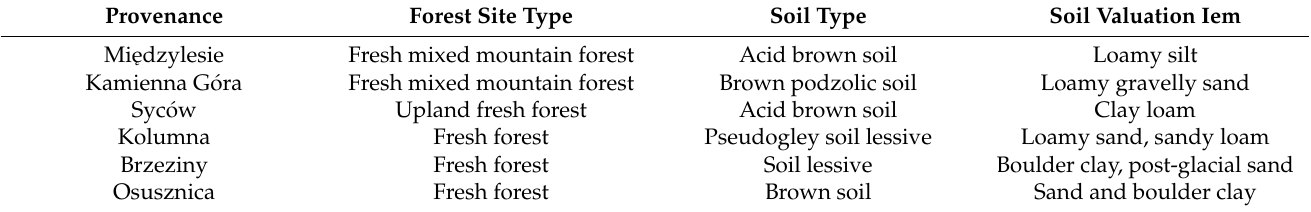
Table 2. Soil conditions of the stands where Abies alba cones were